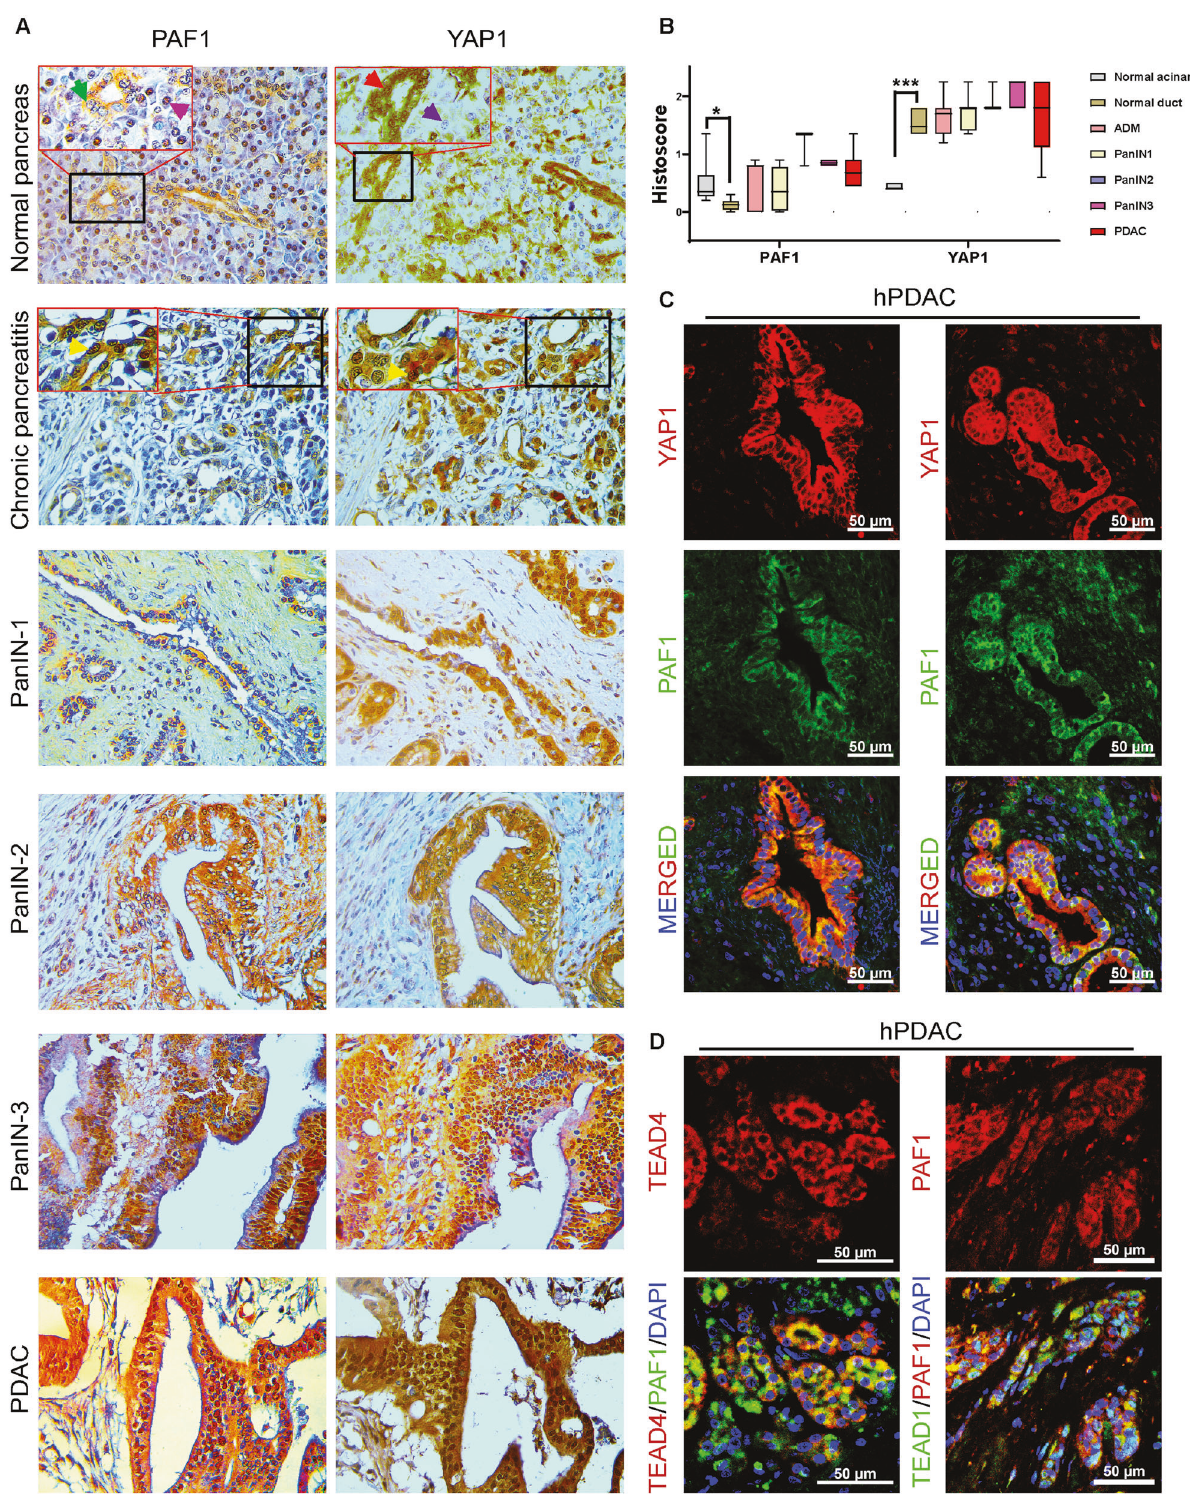
Fig. 1 PAF1 co-expressed with YAP1 in human PanINs and PDAC samples but not in normal pancreas. A Immunohistochemical analysis of PAF1 and YAP1 in PDAC progression tissue samples. The green arrowhead in the magni fi ed region of the normal pancreas points to the duct cell with no or low PAF1 staining, while the pink arrowhead in the magni fi ed region points to the acinar cell with PAF1 staining. On the other hand, the red color arrowhead in the magni fi ed region of the normal pancreas points to the duct cell with YAP1 staining, while the blue color arrowhead points to the acinar cell with no YAP1 staining. In addition, the yellow color arrowhead in chronic pancreatitis tissue samples points to the metaplastic ducts with PAF1 and YAP1 co-expression. Images were captured at ×20 magni fi cation. B A histoscore was calculated by multiplying intensity and positivity. Data represent mean ± SD. p-values were calculated using ordinary one-way ANOVA (multiple comparisons). ∗ p < 0.05, ∗∗ p < 0.01, ∗∗∗ p < 0.001. C , D Immuno fl uorescence images of human PDAC tissues stained with PAF1, YAP1, TEAD4, TEAD1, and DAPI. Scale bar 50